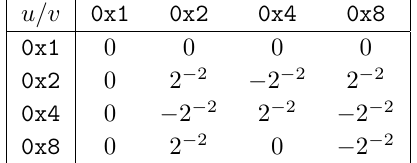
Table 6: Correlation c ( u, v ) of the Sbox of PRESENT when u and v are 1-bit linear